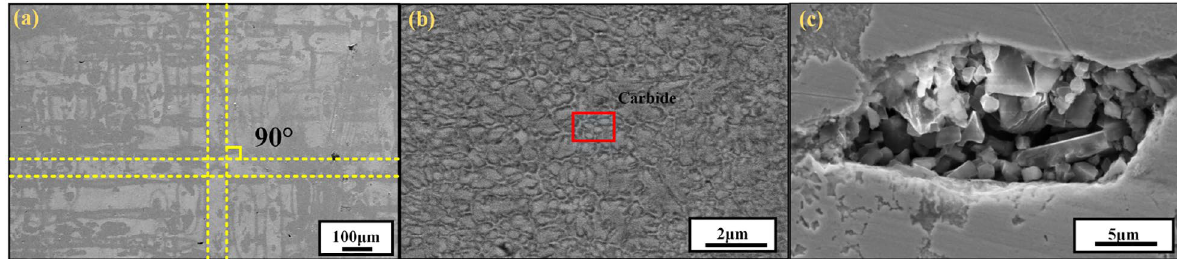
Figure 11 a The 90° rotation angle of each layer in SLM process, b Surface morphology with a network structure, c Micro-cracks